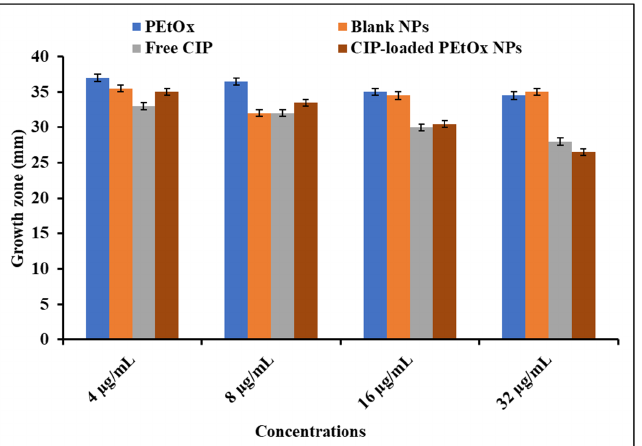
Figure 2. Bactericidal effects of PEtOx, blank NPs, free CIP, and CIP-loaded PEtOx NPs against P. aeruginosa .